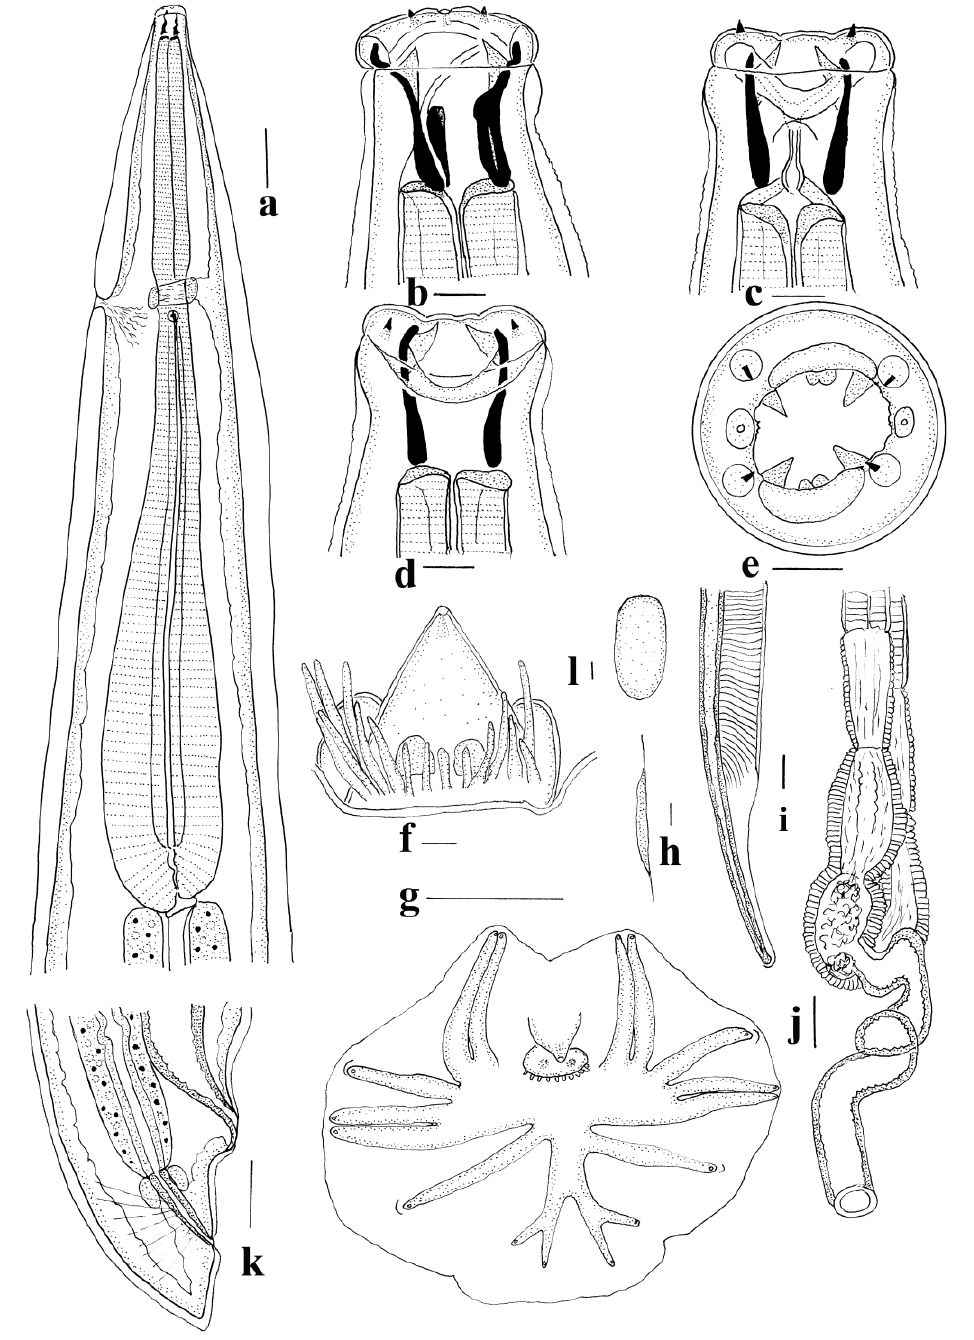
Figure 5. Wallabicola dissimilis n. comb. ( a ) Anterior region, lateral view; ( b ) Buccal capsule, lateral view; ( c ) Buccal capsule, dorsal view; ( d ) Buccal capsule, ventral view; ( e ) Buccal capsule, apical view; ( f ) Genital cone, dorsal view; ( g ) Bursa, apical view; ( h ) Gubernaculum, lateral view; ( i ) Spicule tip, lateral view; ( j ) Vagina and ovejector, lateral view; ( k ) Female tail, lateral view; ( l ) Gubernaculum, dorsal view. Scale-bars: ( a , g , j ), 0.1 mm; ( b – f , h , i , l ), 0.01 mm. Male (measurements of 10 specimens). Length 11–16 (13.6); maximum width 0.41–0.48 (0.45); buccal capsule 0.025–0.038 (0.029) deep, 0.018–0.023 (0.020) wide; oesophagus Additional material examined : from Vombatus ursinus : New South Wales: 5 ♂♂ , 20 ♀♀ , 0.89–1.10 (1.01) long; nerve ring, excretory pore and deirid 0.30–0.40 (0.35), 0.32–0.40 Coolangubra State Forest (N 1511); 12 ♂♂ , 22 ♀♀ , composite collection from Bondo State (0.36) and 0.34–0.41 (0.38) from anterior end respectively. Bursa short, stout; lateral and Forest, Nimmo and Tharwa (N 1116); Victoria: 2 ♂♂ , 4 ♀♀ , Mount Pinnebar (SAM 13924). ventral lobes fused, ventral lobes joined ventrally; dorsal lobe shorter than